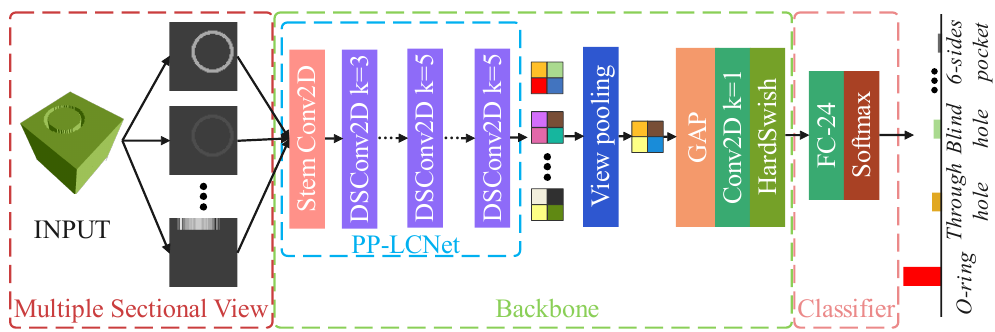
Figure 7. A detailed view of MsvNetLite. Table 2. Configuration details of MsvNetLite; k = 3 denotes convolution kernel size is set to 3, and SE denotes whether to use the Squeeze-and-Excite module. And if SE is set to (cid:88) , it means Squeeze-and-Excite module is